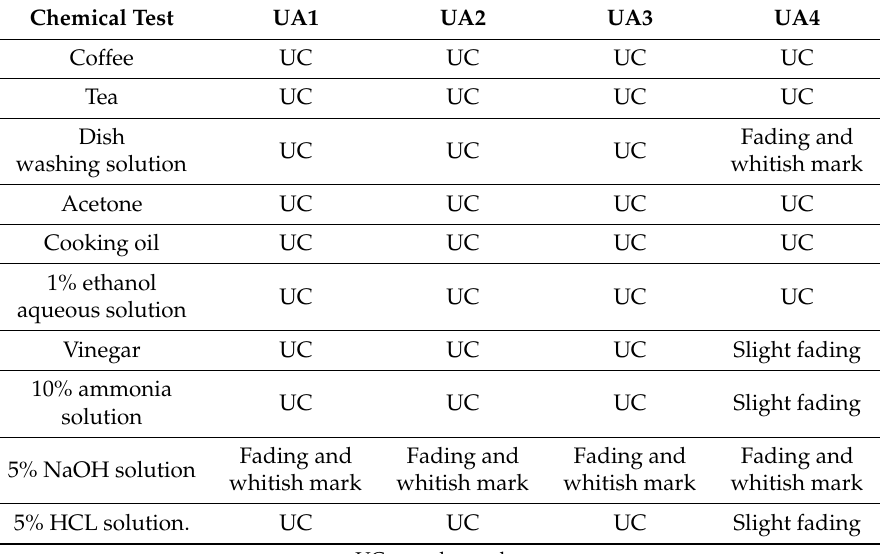
Table 8. The cured film appearances, after 24 h chemical